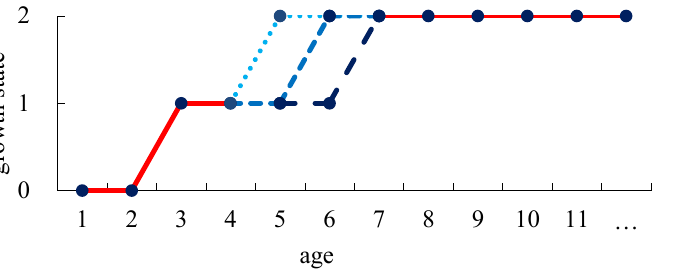
Figure 6. Generalized three-stage growth process of farmland shelterbelts (red line shows the stable growth process for farmland shelterbelts in 1–4 years and ≥ 7 years, and blue lines show the possible growth process for farmland shelterbelts in 5–6 years).